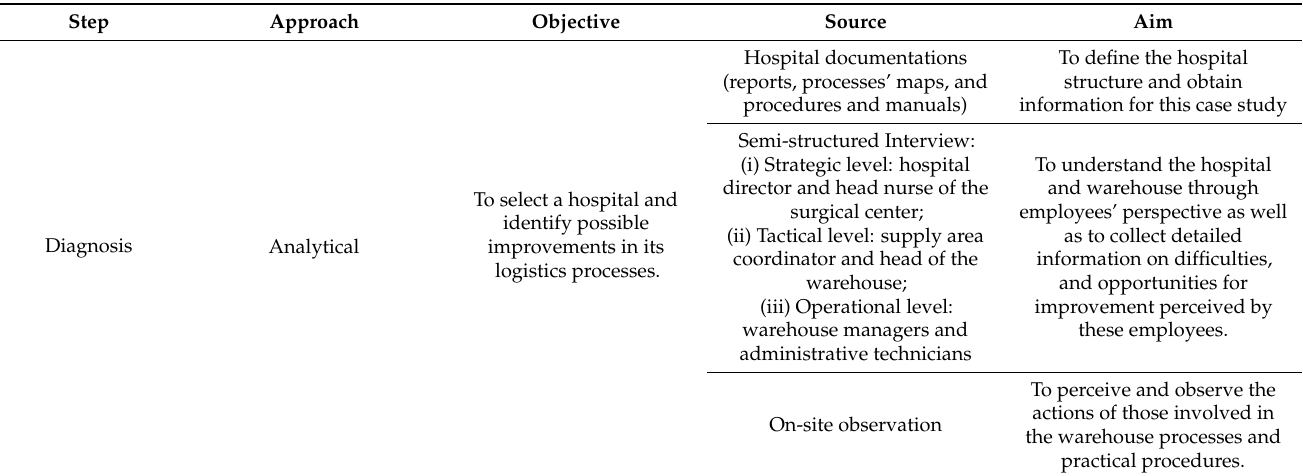
Table 1. Methodological